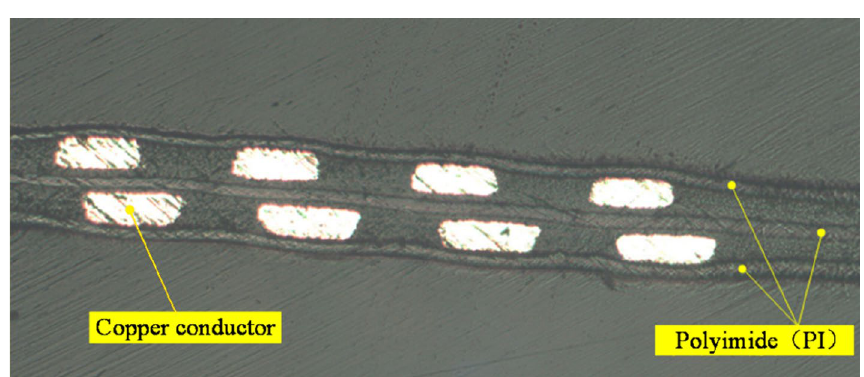
Figure 3. Fracture morphology of flexible eddy current array sensor observed under metallographic microscope.